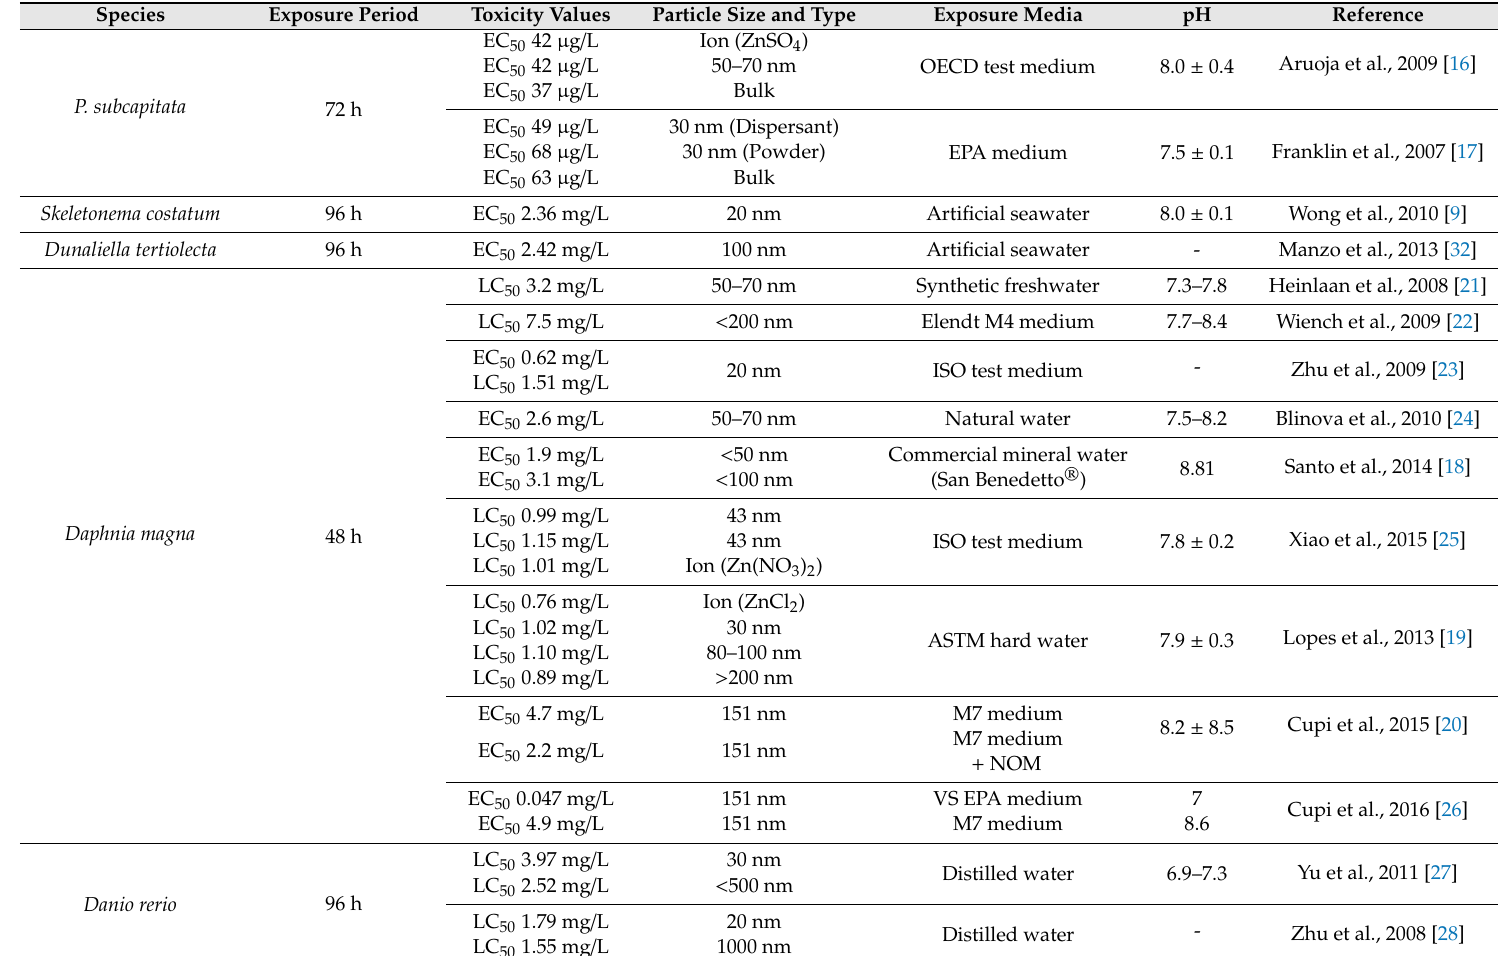
Table 1. Summary of ecotoxicity of ZnO NPs in the previous